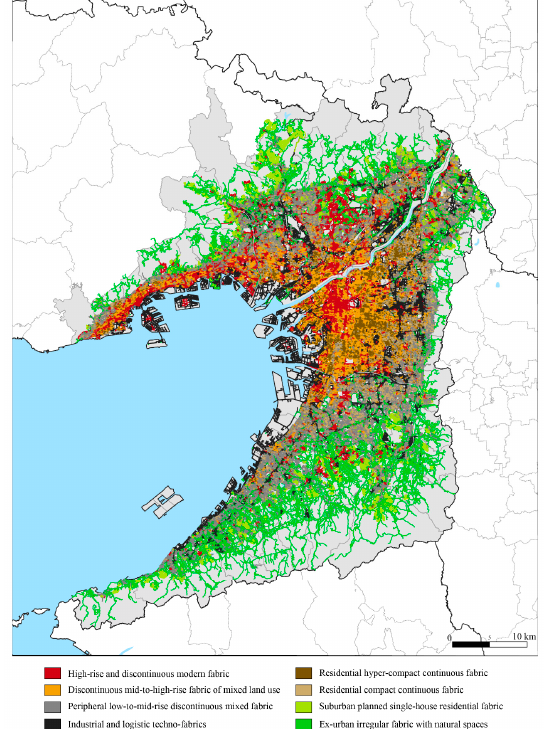
Figure 4. Clustering result of multiple fabric assessment. Dataset available at https: // zenodo.org / record /